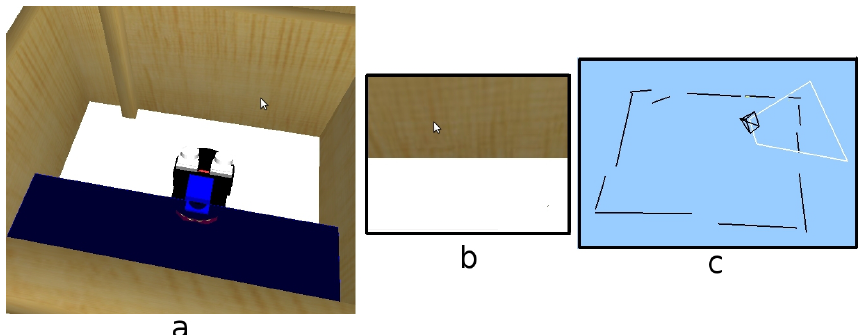
Figure 12. ( a ) Situation; ( b ) Instantaneous image; ( c ) Short-term